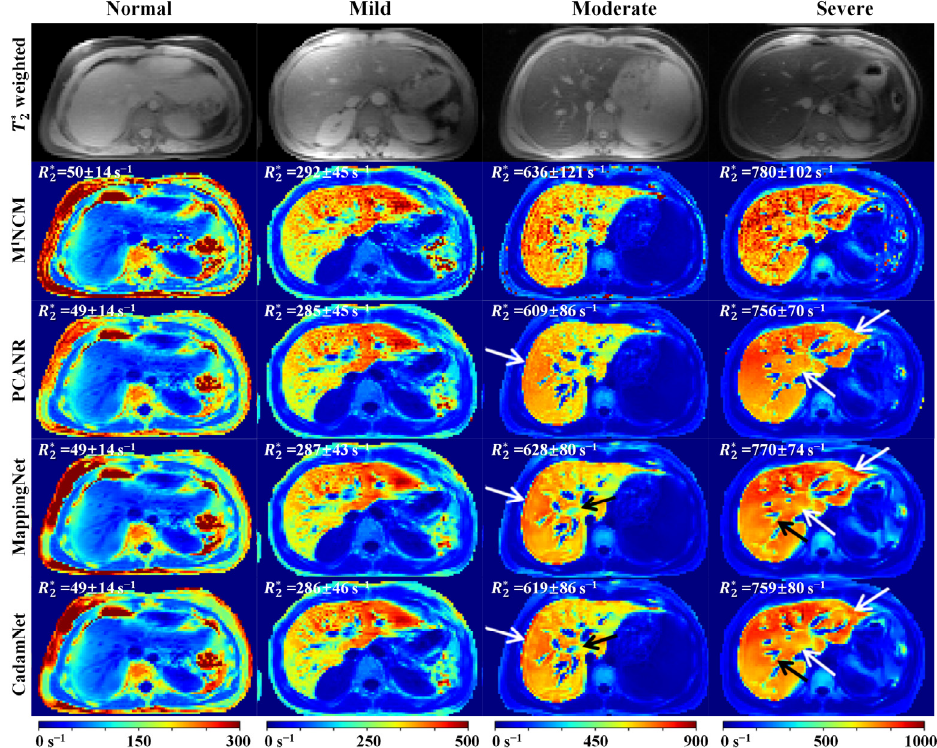
Figure 9. R2* maps for four representative real human liver data. The first row shows the T2*- weighted images at the first echo time (TE = 0.93 ms). The second-to-final rows show the R2* maps reconstructed using M 1 NCM, PCANR, MappingNet, and the proposed CadamNet methods. The mean and standard deviation of R2* values in liver parenchyma (excluding vasculature) are shown in the top-left corner of the R2* map.